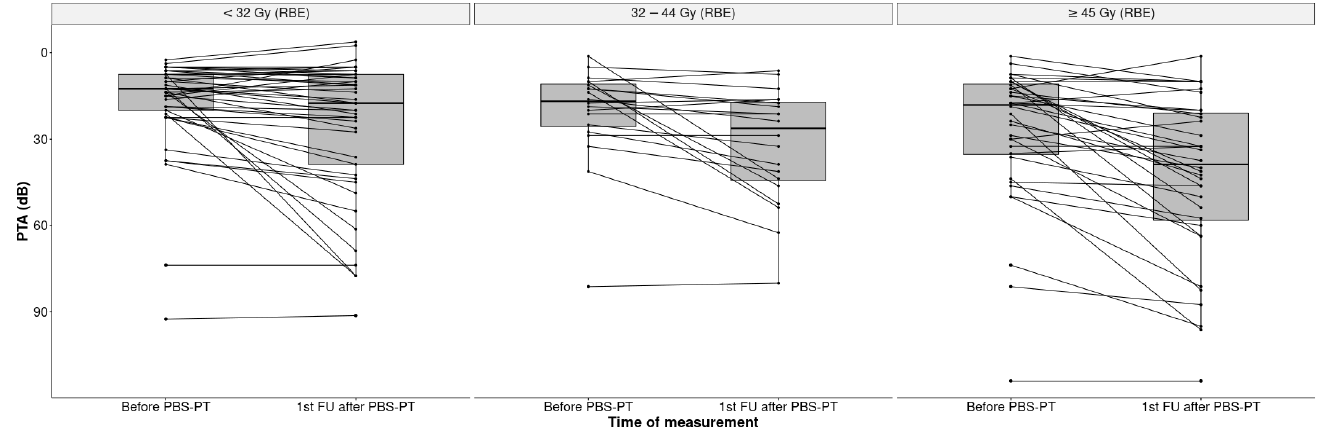
Figure 2. Boxplots of PTA (dB) in all 101 ears before and after PBS-PT according to the cochlear dose in Gy (RBE) (<32, 32 – 44, ≥ 45 Gy).